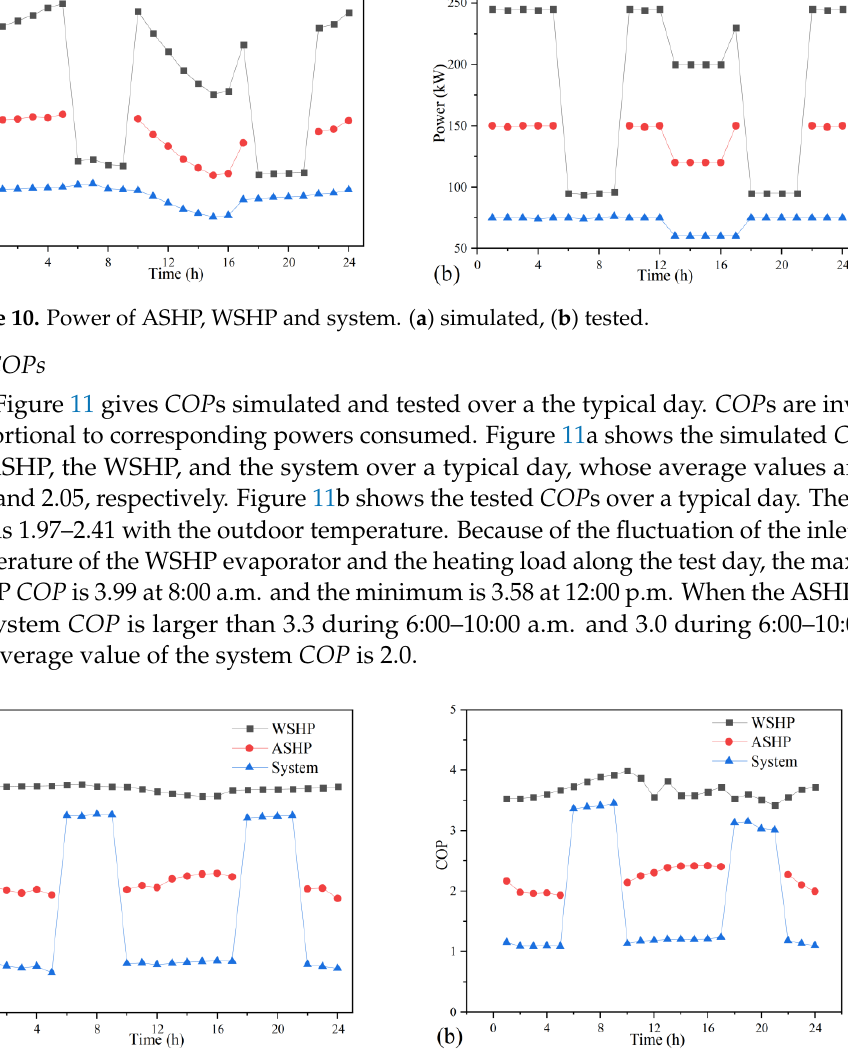
Figure 11. COP s of the ASHP, the WSHP, and the system: ( a ) simulated, ( b ) tested.